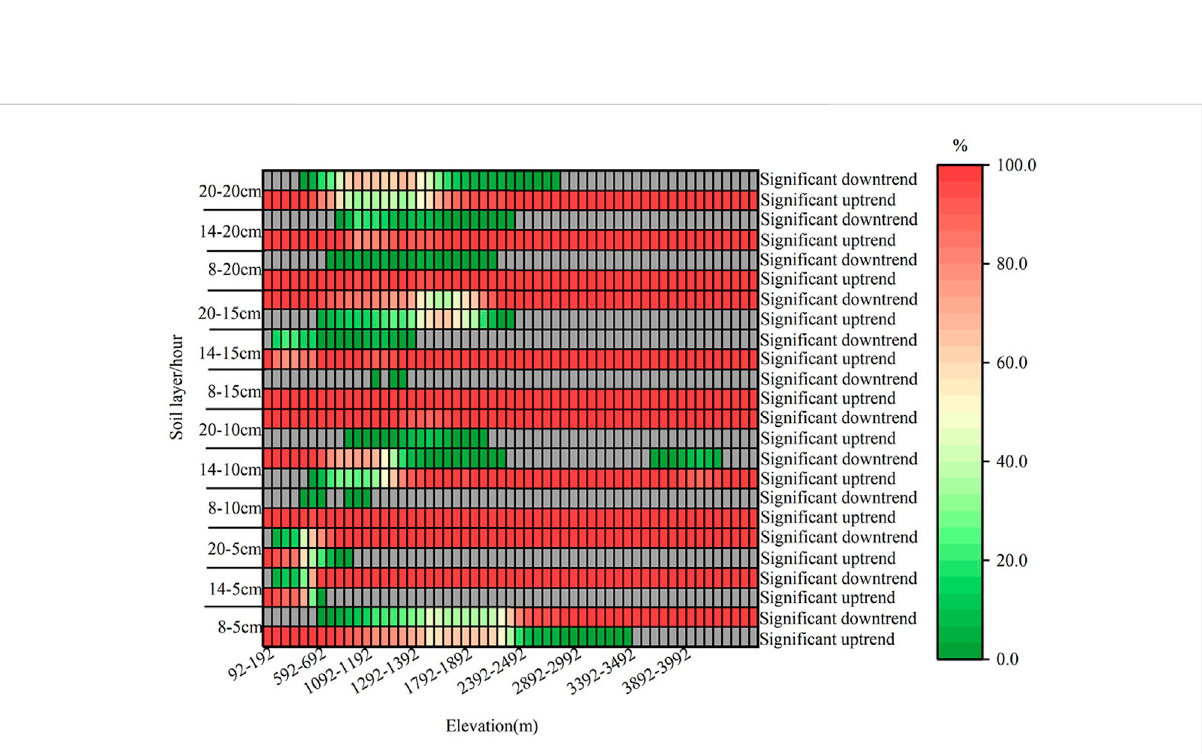
FIGURE 12 Percentage of 5 – 20-cm soil temperatures with signi fi cant uptrend and downtrend at different elevations from 1961 to 2020 (gray shaded area indicates the percentage without signi fi cant uptrend and